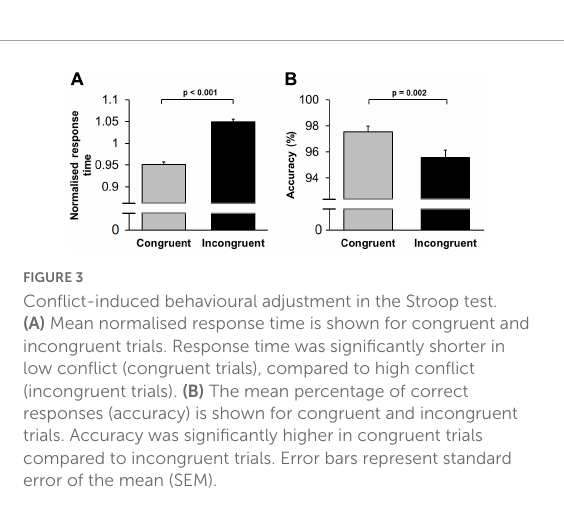
percentage of correct trials. The ANOVA included Practice (first/second stage), Conflict (congruent/incongruent), and Sound (music/noise/silence) as within-subject factors, and Sex (female/male) as a between-subject